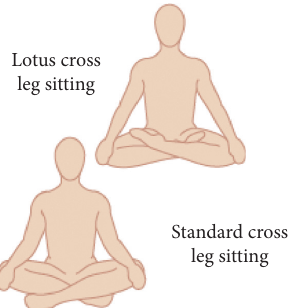
Figure 3: Cross-leg sitting (standard and lotus positions)